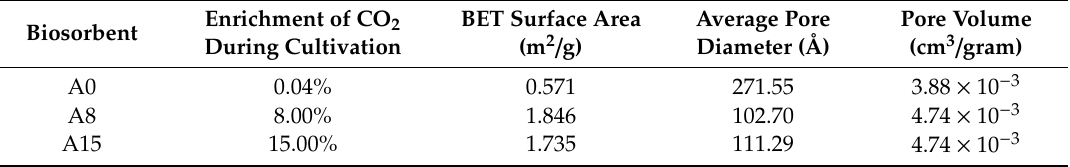
Table 2. The BET analysis results for the three types of biosorbent (average particle diameter size range of 40.0 µ m, in the range of 15.5 to 82.6 µ